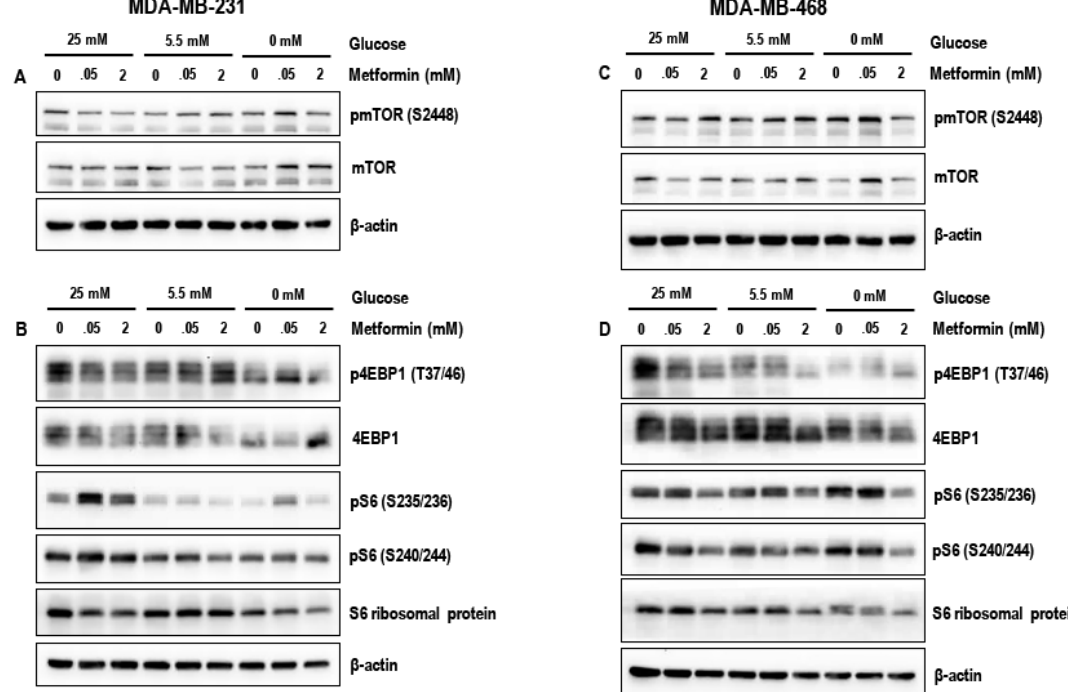
Figure 4. Representative western blots ( A ) and ( B ) show the effect of metformin (50 M and 2 mM) in 25 mM glucose, 5.5 mM glucose, and zero glucose/glucose-starved conditions on the levels of pmTOR (S2448), mTOR, p4EBP1 (T37/46), 4EBP1, pS6 (S235/236), pS6 (S240/244), and S6 ribosomal protein in MDA-MB-231 cells. Representative western blots ( C ) and ( D ) show the effect of metformin (50 µ M and 2 mM) in 25 mM glucose, 5.5 mM glucose, and zero glucose/glucose-starved conditions on the levels of pmTOR (S2448) and mTOR, p4EBP1 (T37/46), 4EBP1, pS6 (S235/236), pS6 (S240/244), and S6 ribosomal protein in MDA-MB-468 cells. β -actin was used as the loading control. Data represented is from 3–4 independent experiments.